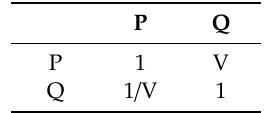
Table 1. Matrix for the pairwise comparison of